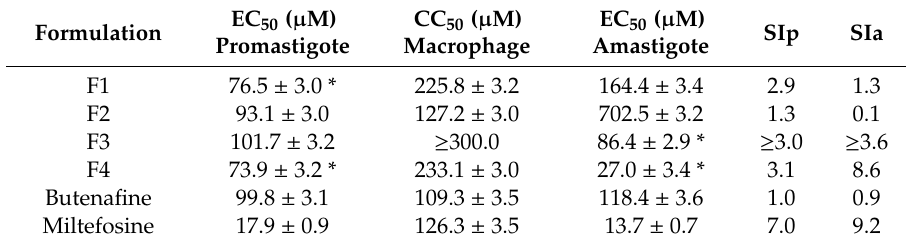
Table 5. Antileishmanial activity of solid B-SNEDDS formulations and butenafine were assayed against promastigote and amastigote forms of L. (L.) infantum . Cytotoxicity was analysed using peritoneal macrophages from BALB / c mice. EC 50 represents the concentration of the formulation that produced a 50% reduction in parasites, while CC 50 represents the concentration of the formulation that produced a 50% reduction of cell viability in treated culture cells with respect to untreated ones. SIp: selectivity index towards promastigotes forms; SIa: selectivity index towards amastigotes